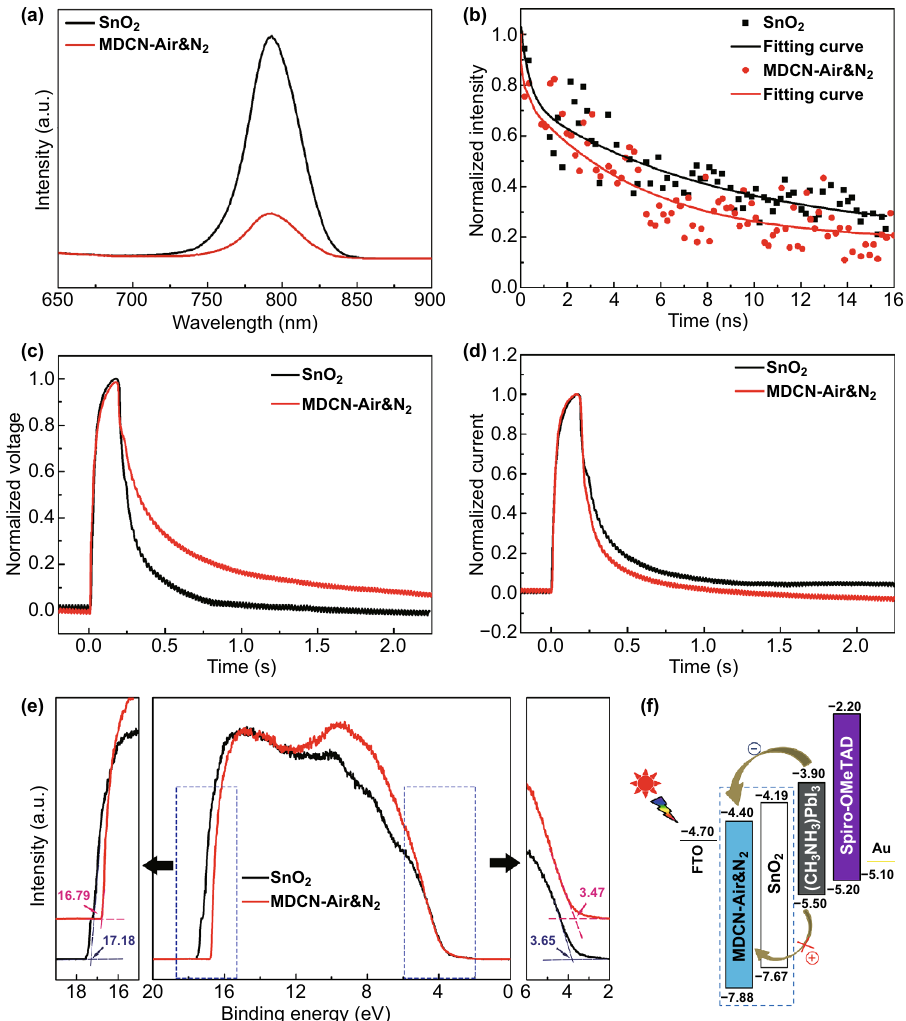
Fig. 8 a Steady‑state PL spectra, b TRPL spectra, c TPV curves, d TPC curves, and e UPS spectra for SnO 2 and MDCN‑Air&N 2 ETLs. f Energy diagram for a working device with potential ETLs signed in the dotted